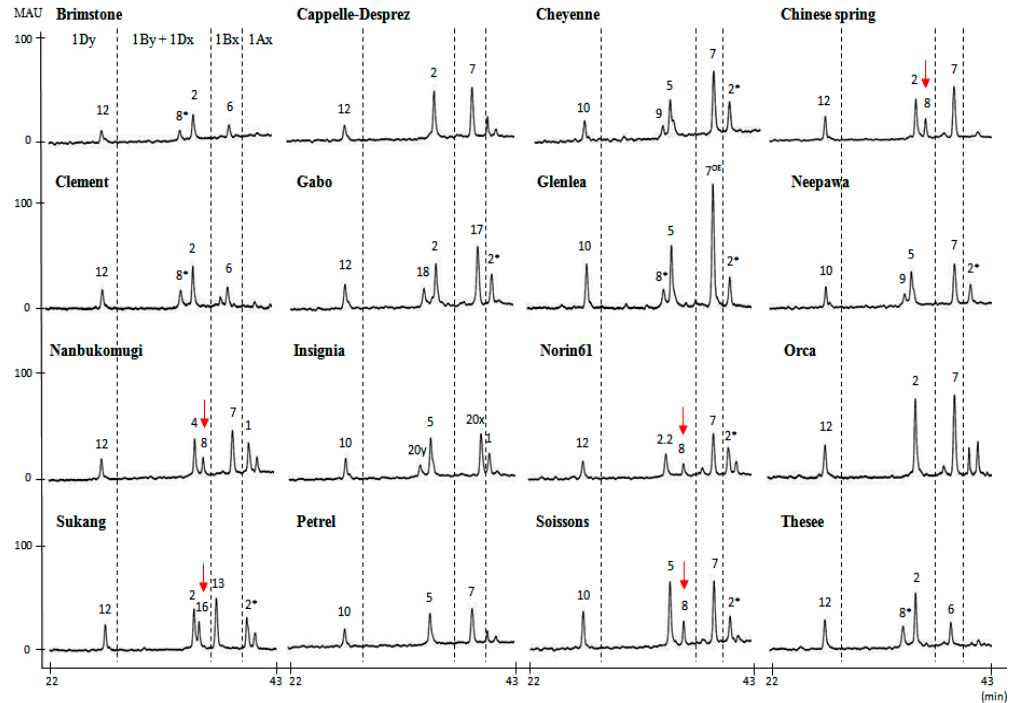
Figure 1. HMW-GS profiles of standard wheat cultivars determined by RP-HPLC. Red arrows point to 1By subunits that elute after 1Dx subunits.